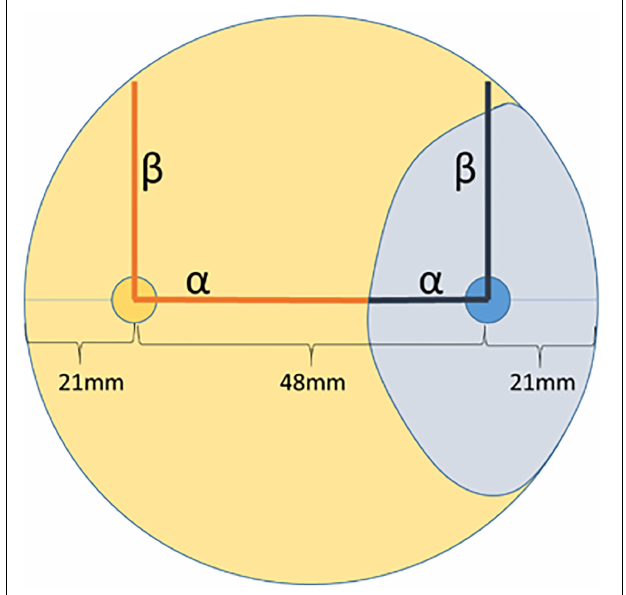
FIGURE 2 | Arrangement of the two-paired culture assay of one fungus (e.g., endophyte) in orange and the other fungus (e.g., pathogen) in blue. Measurement was along the alpha and beta axes. The light orange and blue areas suggest possible growth areas of the fungi and how their growth could be